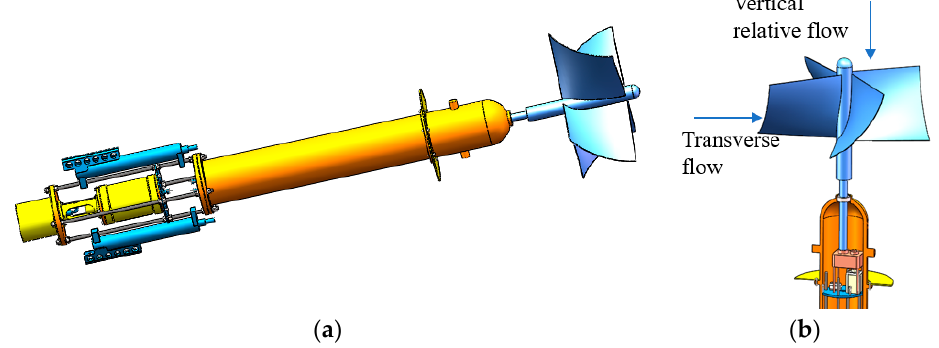
Figure 2. ( a ) 3D drawing of profiling float; and ( b ) Schematic diagram of the internal profile of the turbine connecting mechanism.